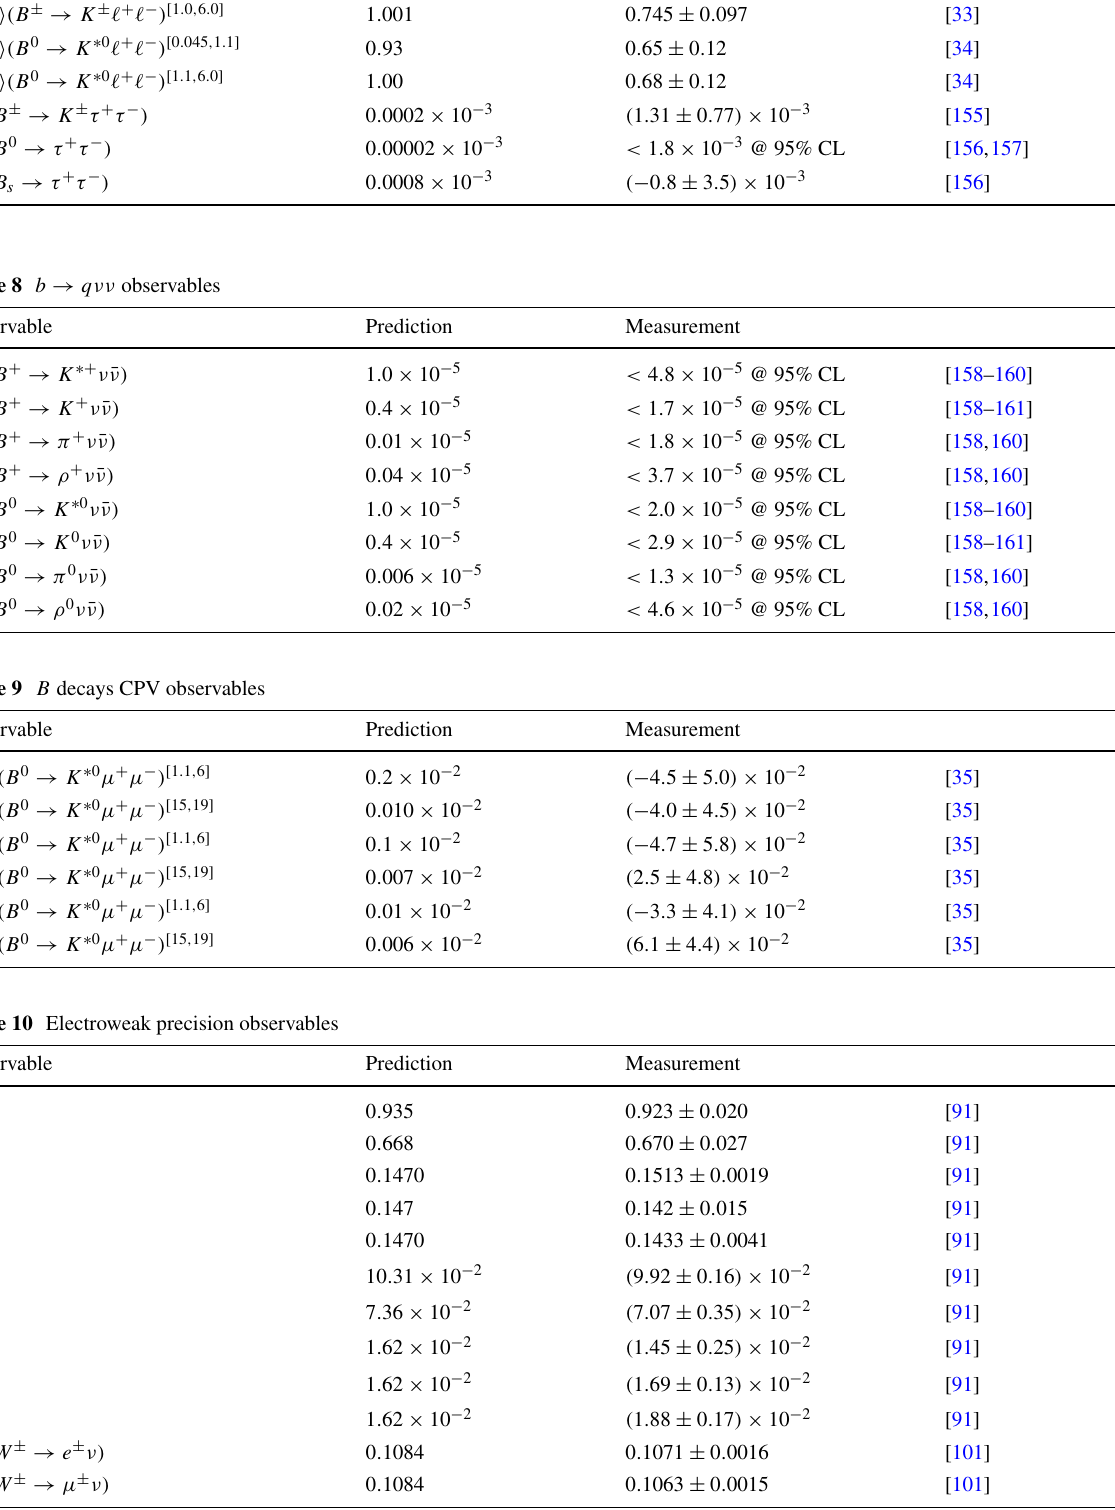
Table 7 Neutral-current LFU-testing observables Observable